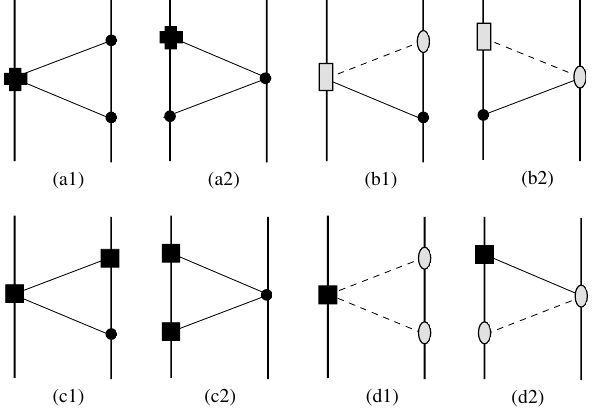
Figure 3 . The Feynman graphs of two-graviton exchange at the NLO quartic-in-spin interaction. These graphs contain all relevant interactions among the mass, spin and spin-induced multipoles up to the hexadecapole. In particular at this nonlinear level there are also interactions with the various multipoles on two different points of the worldline, which occurs as of the NLO spin- squared sector [4, 13, 14], such as a spin dipole and a spin-induced quadrupole or two spin-induced quadrupoles on the same worldline. The graph (a1) contains a new two-graviton coupling to the